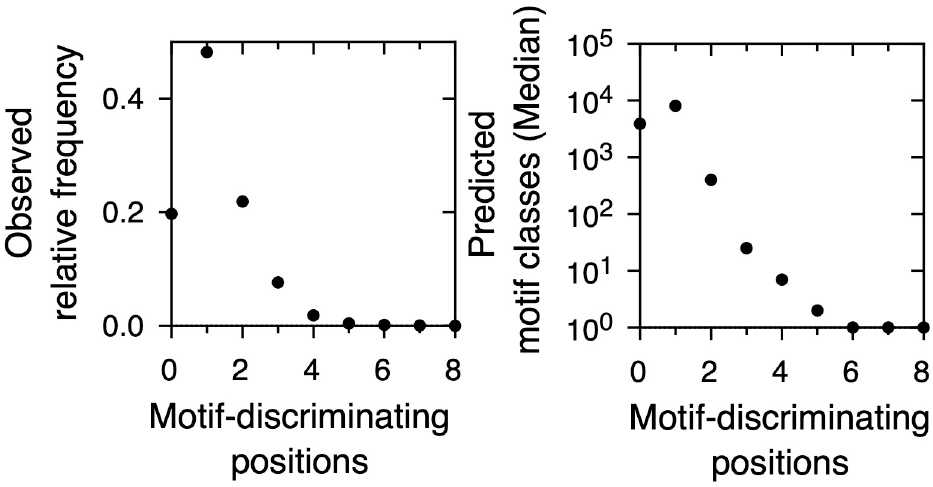
Fig 4. Number of potential linear motif classes as deduced from the ELM database. (Left) Number of motif- discriminating positions for all possible linear motif pairs in the database. The total number of pairs is 14706. (Right) Number of potential linear motif classes for different numbers of motif-discriminating